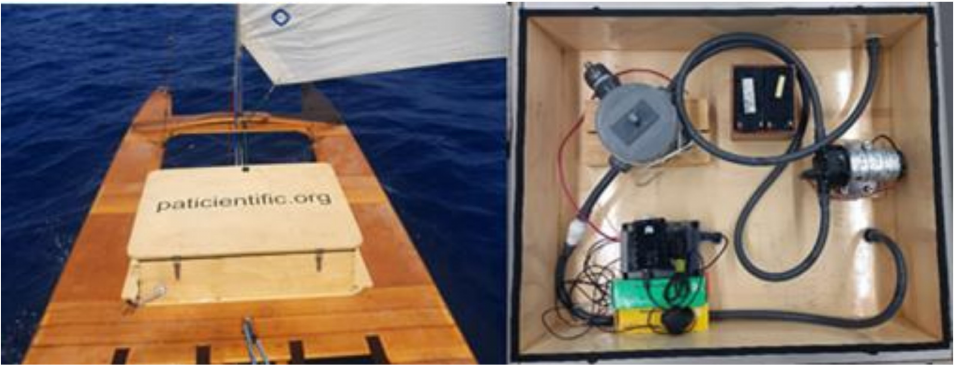
Figure 2. ( Left ) Removable on-board multiparametric box installed in a PV. ( Right ) Detail of the interior configuration of the removable on-board multiparametric